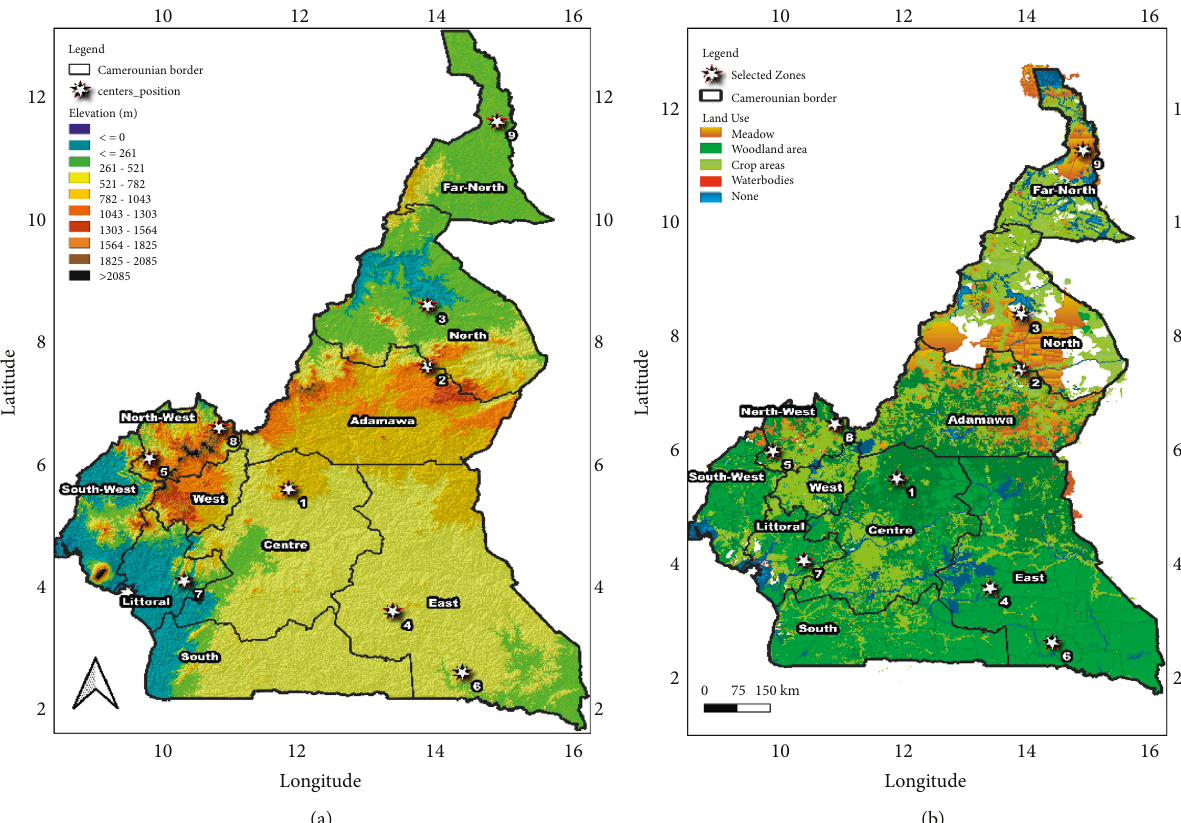
Figure 1: Topography of the study area (left) and land use map (right) using OpenStreetMap data (https://download.geofabrik.de/africa/ cameroon-latest-free.shp.zip). The stars identified the target zones found with the K -mean classification